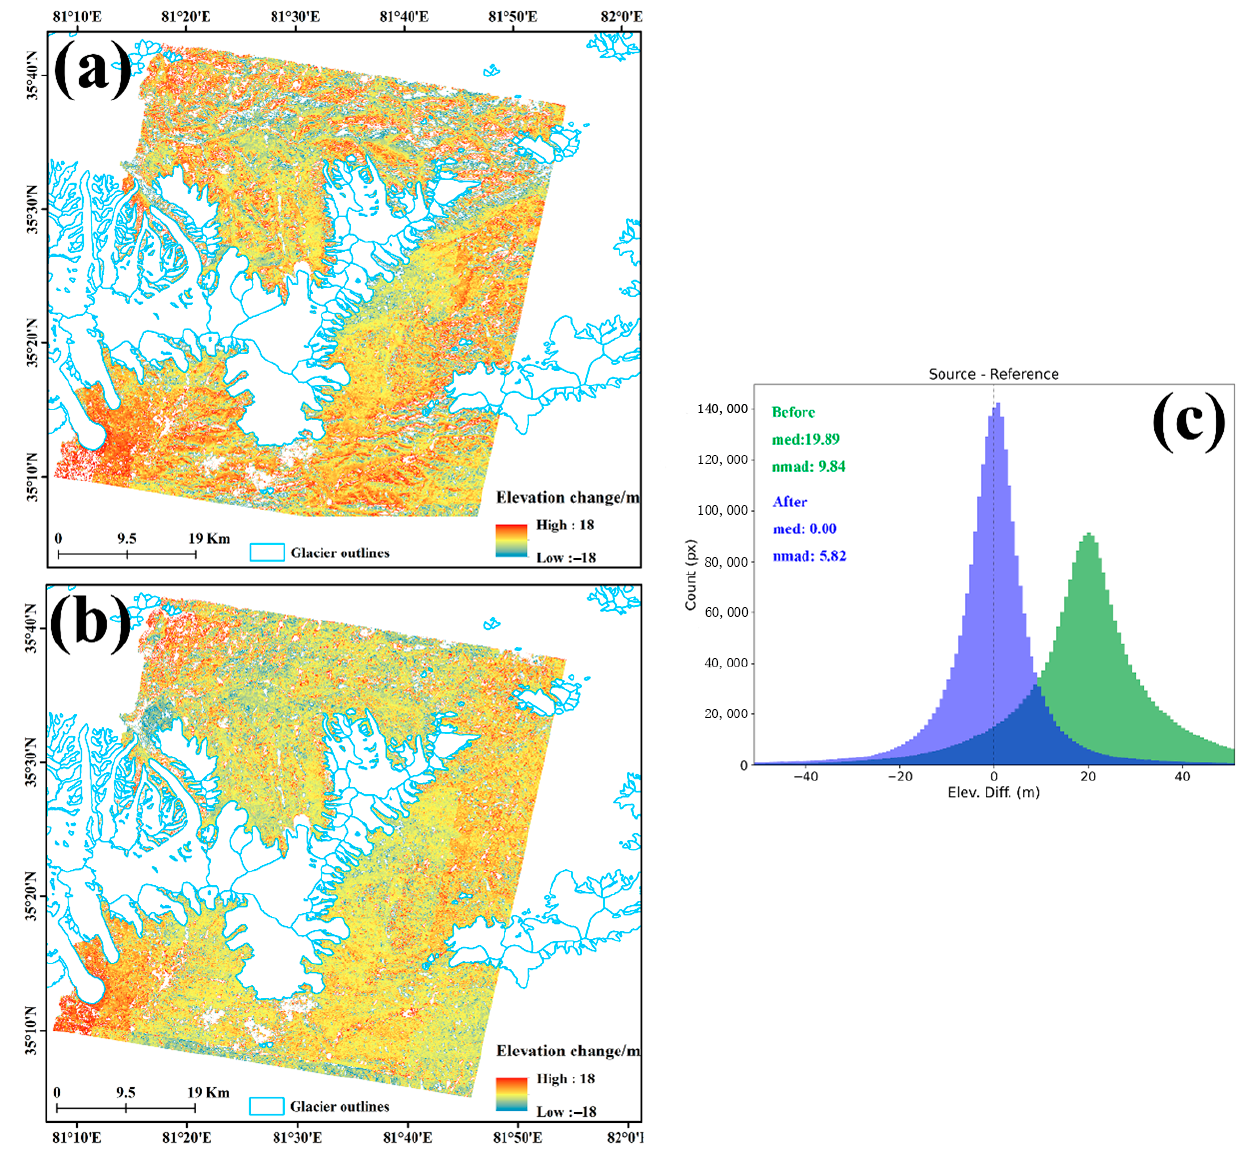
Figure 2. One sampled ASTER DEM for 2002, showing the DEM difference ( a ) before and ( b ) after co-registration; ( c ) is the statistical analysis of this process (in the subplot ( c ), med indicates median, and NMAD is normalized median absolute deviation).